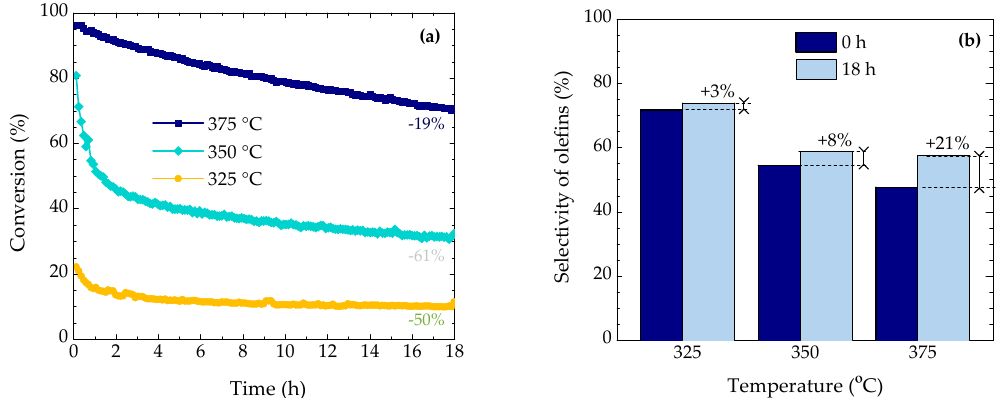
Figure 1. ( a ) Effect of reaction temperature on the evolution of DME conversion with time on stream and its relative decrease after 18 h. ( b ) Selectivity of olefins at 0 and 18 h at 325, 350 and 375 °C. Annotations refer to ( a ) the decrease in the DME conversion values and ( b ) the increase in the selectivity values.